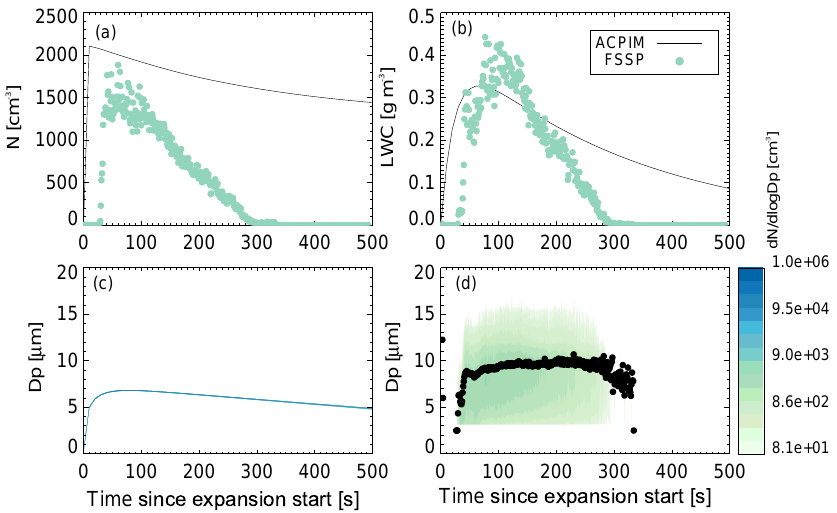
Figure 8. Comparison of ammonium sulfate measurements (experiment 9, run 2; see Table 1) and ACPIM simulation of number concentra- tions (a) , LWC (b) , and size distribution and mean volume diameter ( c : simulated, d : measured).